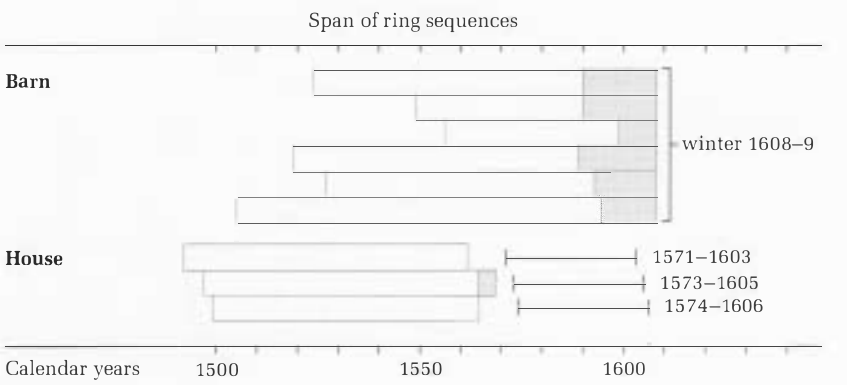
Figure 7 Bar diagram representing the relative positions of overlap of the dated timbers from two phases of building at Home Farm, Newdigate, Surrey, demonstrating how these two phases can be distinguished on the basis of their tree-ring series. The shaded portions represent the sapwood rings and the horizontal lines (lower right) indicate the most likely range of felling dates. in the period 1574-1603, whereas the east end of the south barn (Fig. 6) was built